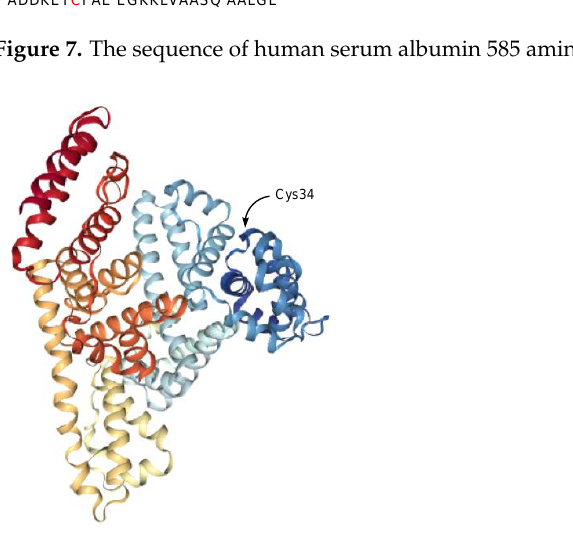
Figure 8. The X-ray crystal structure of human serum albumin (1BM0).